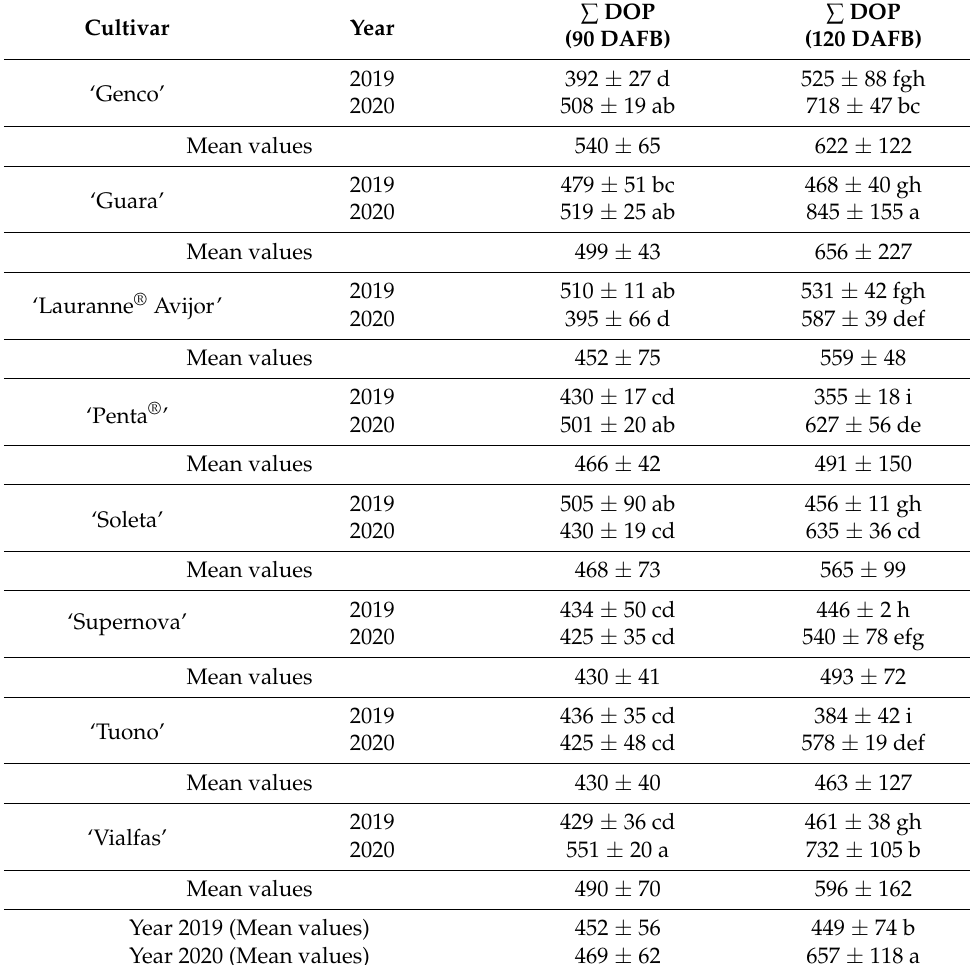
Table 7. Values of ∑ DOP calculated by adding the absolute values of the DOP index determined for every nutrient. Single nutrient DOP indexes were obtained comparing mean values to the average C ref proposed by Mills et al. [39]). Data are presented as mean ± standard deviation. Different lowercase letters on the columns indicate differences between means (Fisher’s test p <